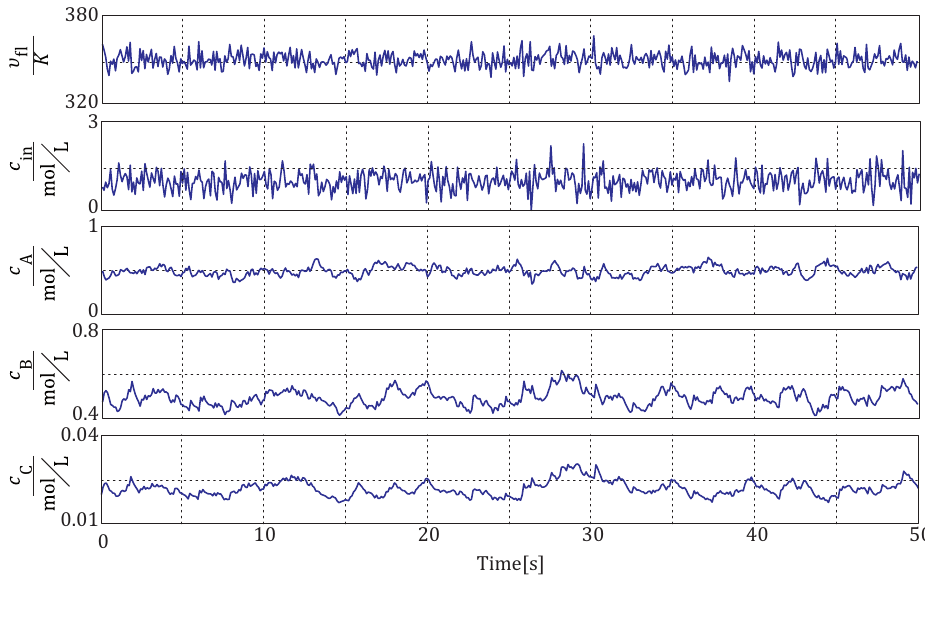
Figure 1. Simulated data from the CSTR used for the analysis.